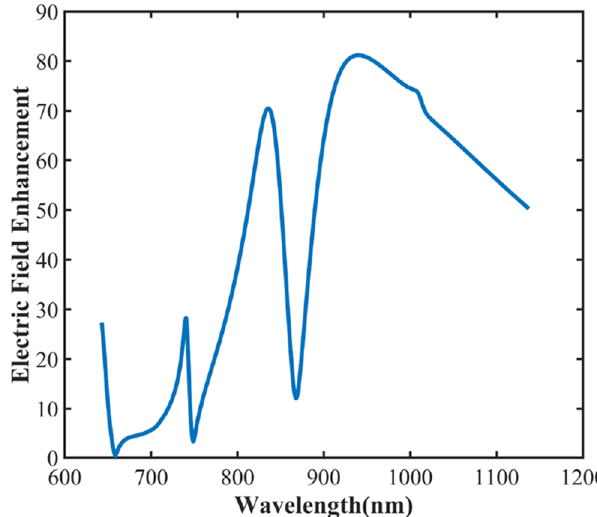
Fig. 6. Electric fi eld enhancement factor FE ð ~ r max ; l Þ at the position of strongest enhancement ~ r max in the nanodisk gap as a function of the free space illumination wavelength l